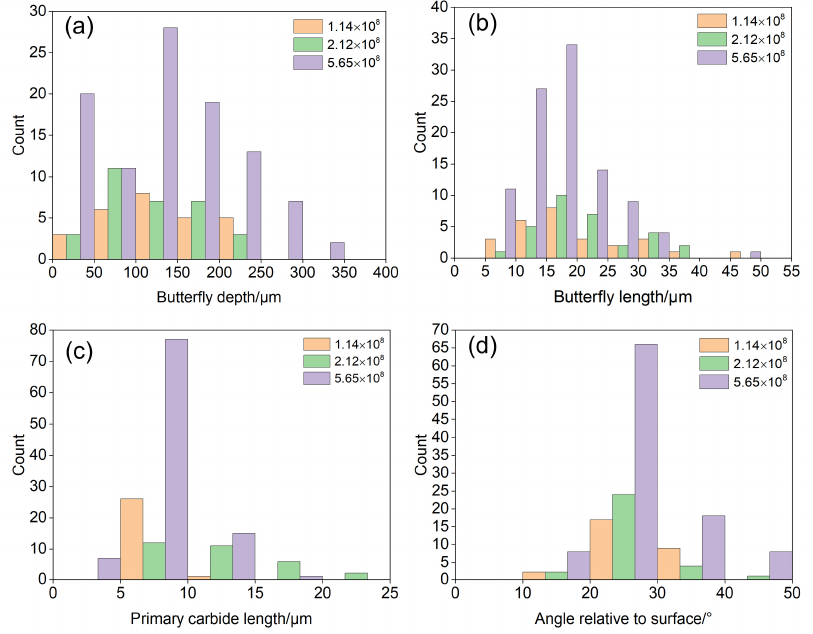
Figure 4. Characteristic parameters of butterflies in the RCF samples tested under 5 GPa: ( a ) frequency histogram of the depth of the butterflies from the surface; ( b ) frequency histogram of the length of the butterflies; ( c ) frequency histogram of the length of the primary carbides associated with the butterflies; ( d ) frequency histogram of the angle.